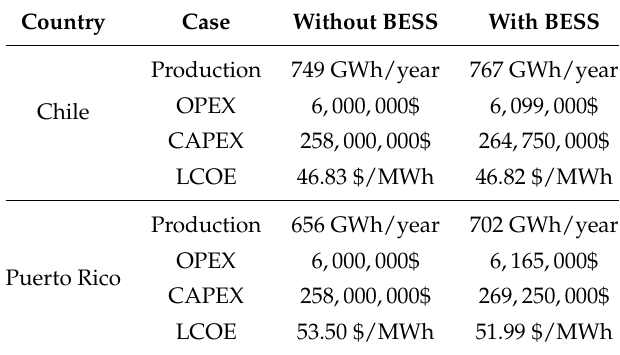
Table 7. USPVP levelized cost of electricity (LCOE) results. OPEX: OPerating EXpenses, CAPEX: CAPital